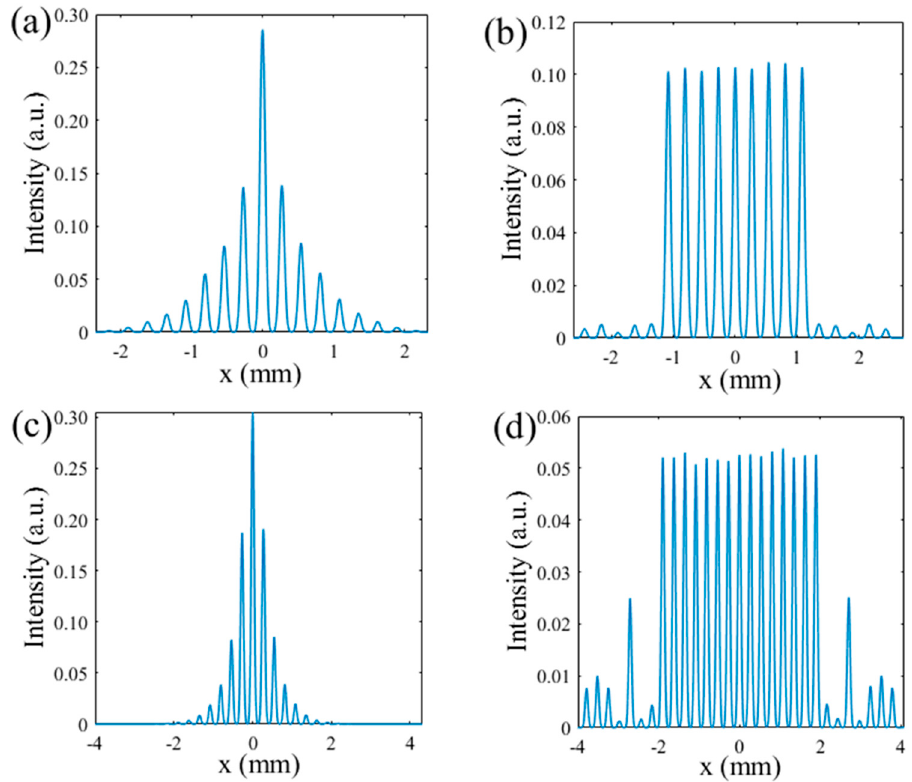
Figure 5. The initial and optimized 1×9 ( a , b ) and 1×15 ( c , d ) beam spot array.